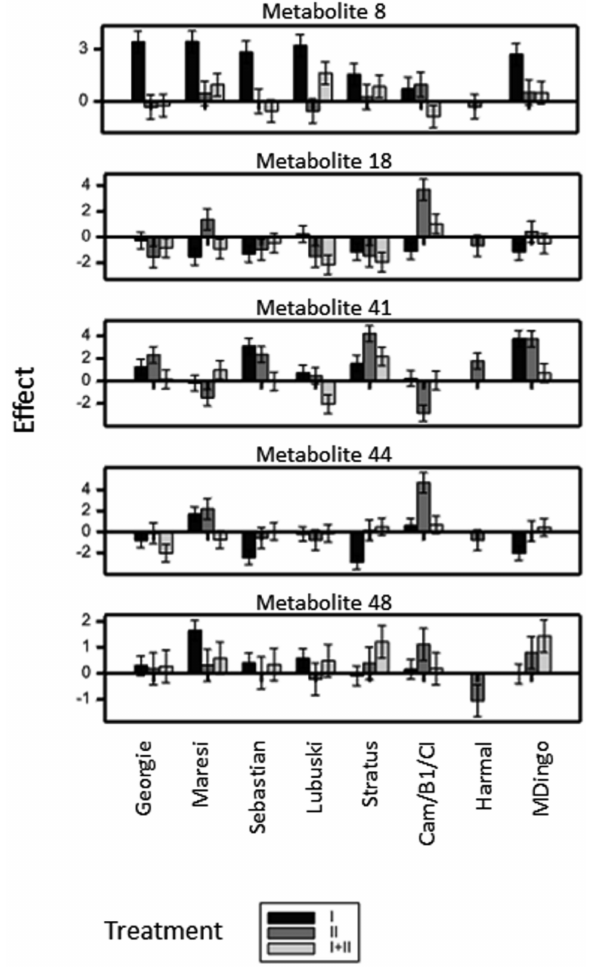
Figure 3. Variety-specific water deficiency e ff ects observed on day 10 of treatment I, II and I + II, for identified metabolites with the e ff ects significantly modified by variety and time under at least one